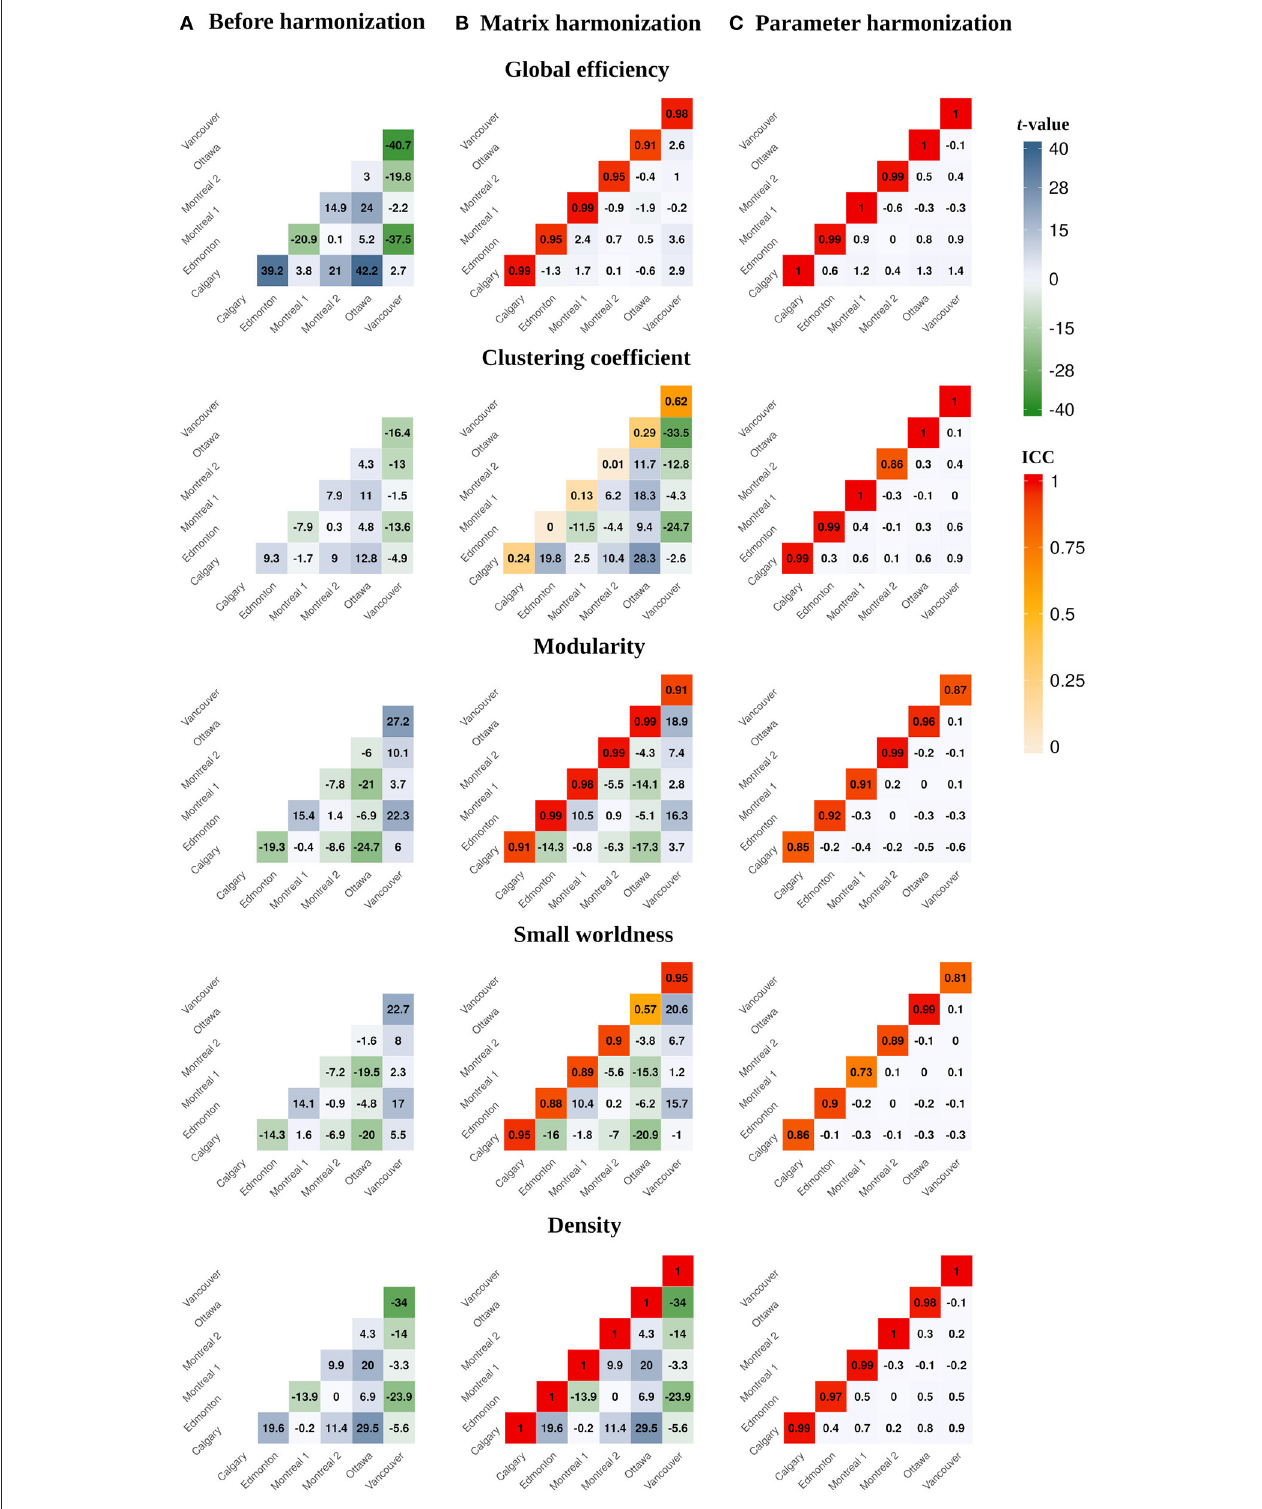
FIGURE 3 | Heatmaps illustrating pairwise between-site differences and t -values (lower diagonal) and within-site ICC values (principal diagonal) for the global network parameters calculated (A) before harmonization, after (B) matrix, and (C) parameter harmonization.